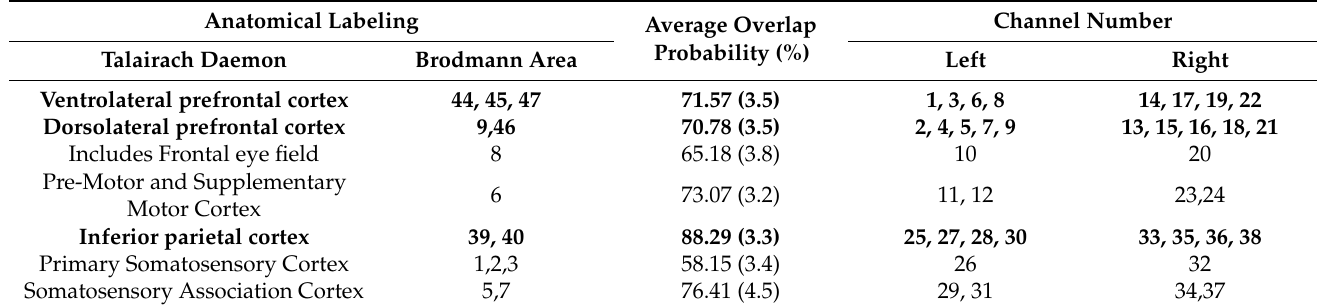
Table 1. Anatomical labeling of near-infrared spectroscopy (NIRS) channel